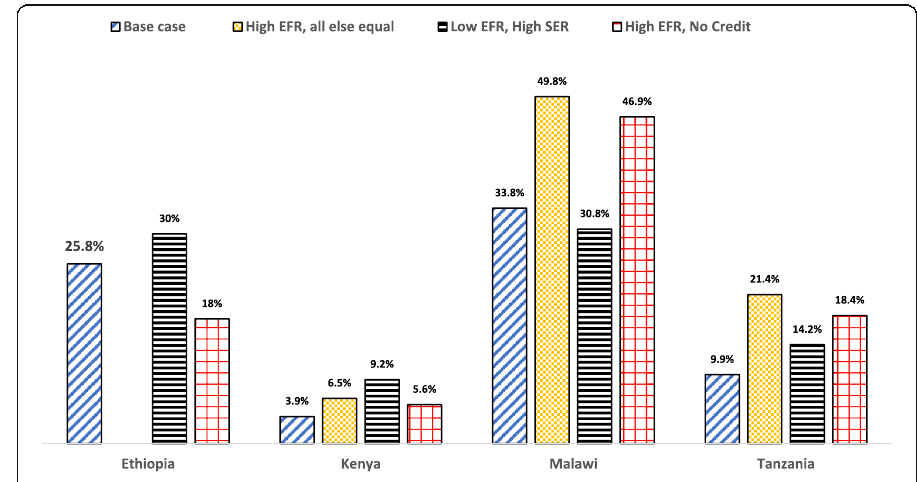
Fig. 2 Simulations involving extension to farmer ratios as a percentage of agricultural budgets in Ethiopia, Kenya, Malawi and